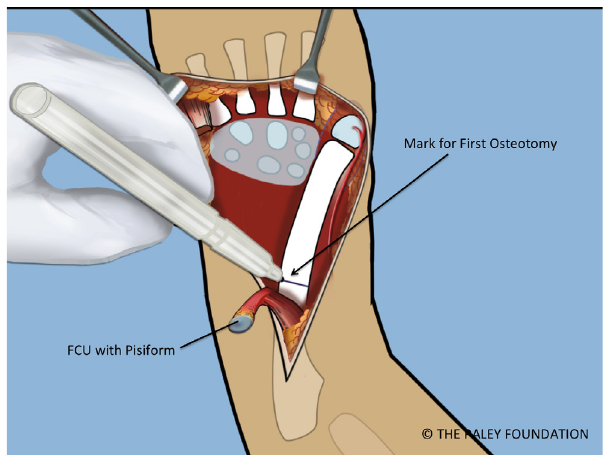
Figure 14. A small plate is affixed to the proximal ulna with two or three